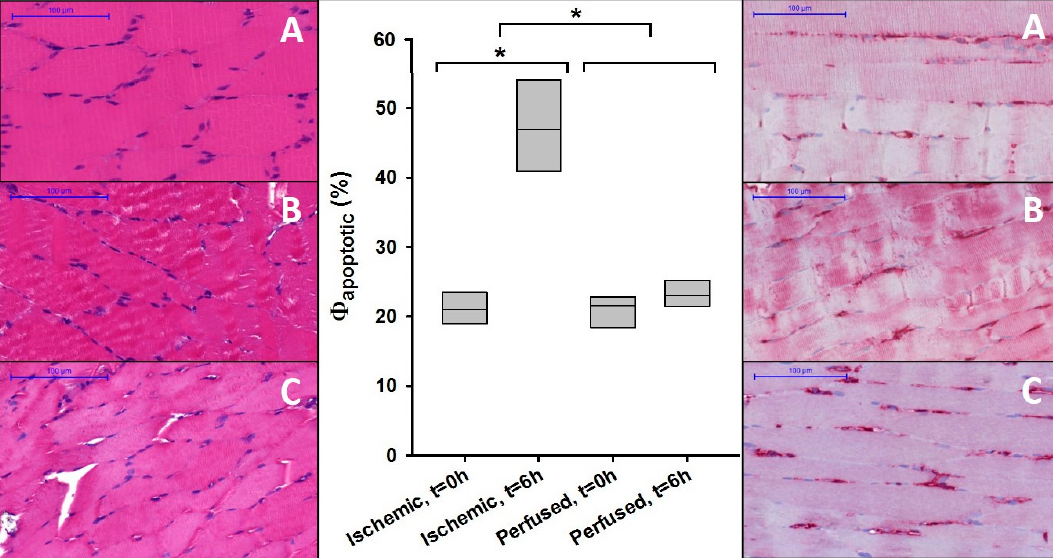
Figure 4. ( Left ) Histological images of the muscles prior to treatment ( A ), after six hours of ischemia ( B ), and after six hours of perfusion ( C ); ( middle ) ratio of annexin-V-stained cell nuclei in relation to the Table 0 h ( * ) Asterisks indicate a statistical significance between values of different times (t = 0 and t = 6 h) or groups (ischemic, perfused); ( right ) histological images of the muscles with annexin V staining prior to treatment ( A ), after six hours of ischemia ( B ), and after six hours of perfusion ( C ); positively stained apoptotic myonuclei appear red, negatively counterstained myonuclei appear blue.